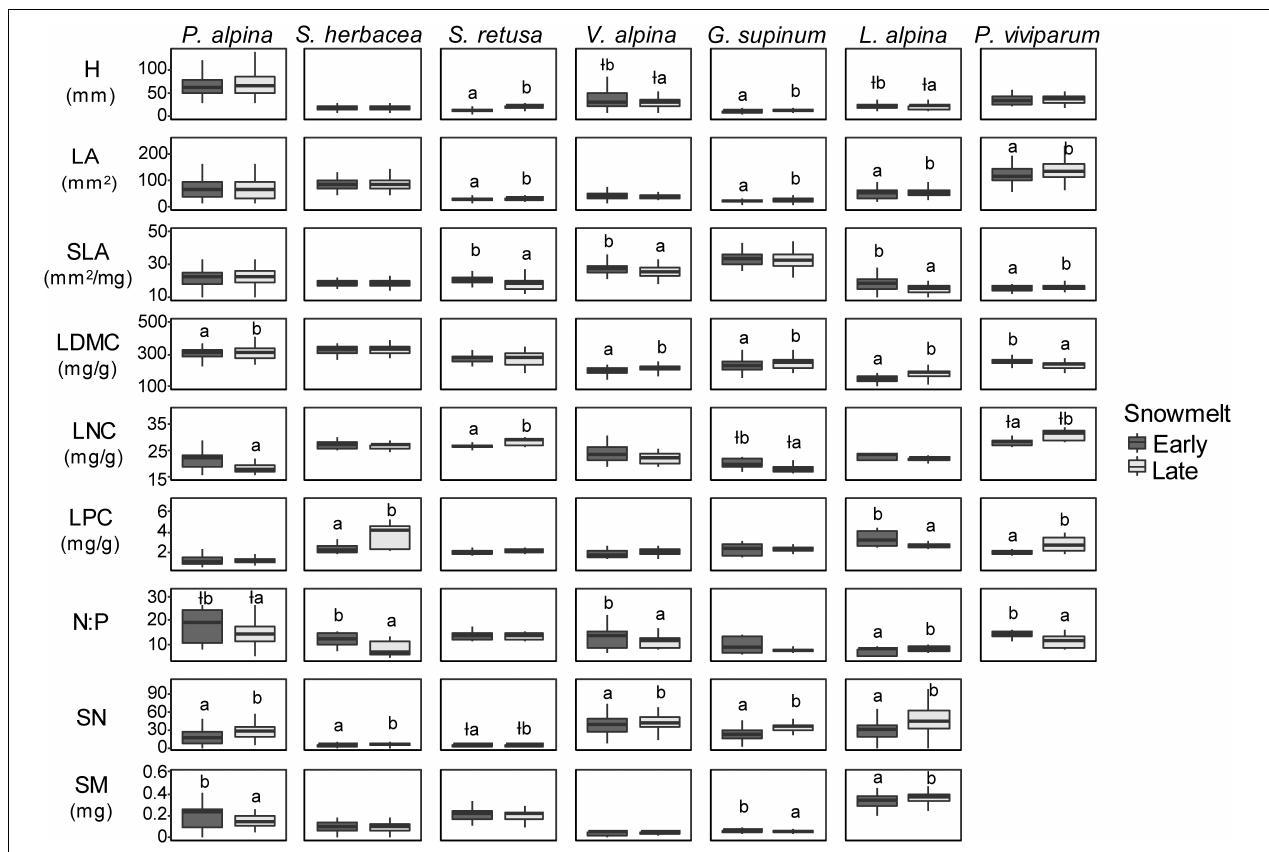
FIGURE 4 | Box-whisker plots for plant traits in the seven snowbed species at early (dark gray boxes on the left-hand side of each panel) and late (light gray boxes on the right-hand side of each panel) snowmelt areas. H, plant height; LA, leaf area; SLA, specific leaf area; LDMC, leaf dry matter content; LNC, leaf nitrogen content; LPC, leaf phosphorus content; N:P, N:P ratio; SN, seed number; SM, seed mass. The species were sampled at two to four sites depending on their occurrence. P. alpina and S. herbacea were sampled for SN and SM at three and two sites, respectively, because they did not produce seeds at the other sites. The boxes comprise the 25th and 75th percentile with the upper and lower whiskers extending from the hinge to the upper and lower 1.5 inter-quartile ranges, respectively. Different letters indicate significant differences ( P < 0.05) between early and late snowmelt areas. The symbol ł before the letters indicates a marginal significance ( P < 0.10). See Supplementary Table S5 for values of median and first and third quartiles of early and late snowmelt groups for each species and each trait. Detailed results of linear mixed effect models are given in Supplementary Table S6